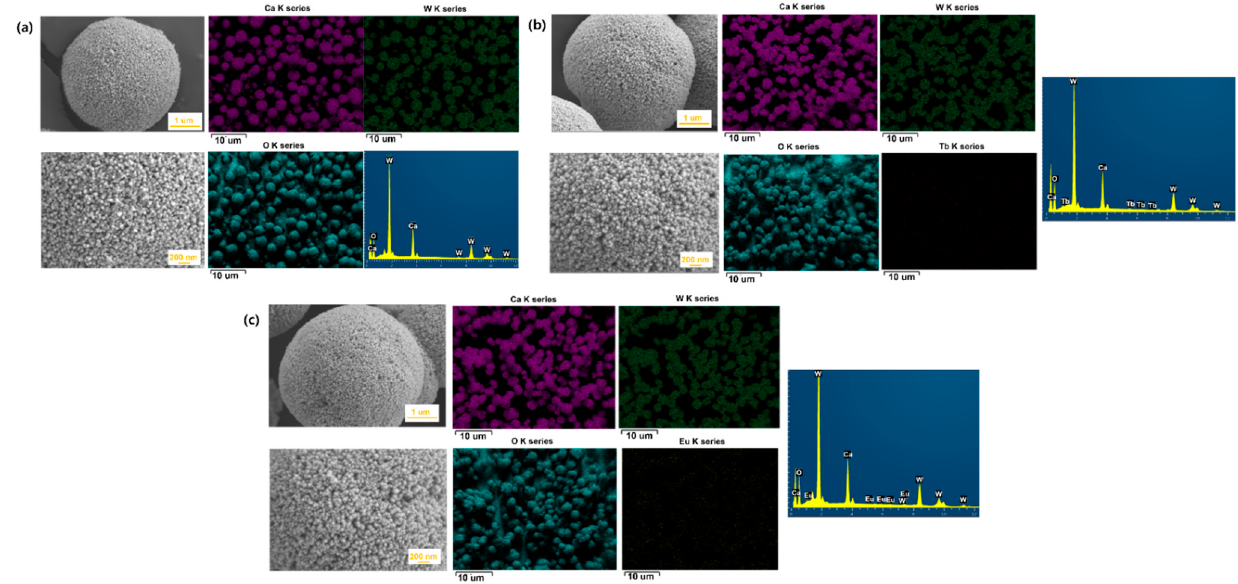
Figure 3. SEM-EDS analysis; ( a ) CaWO 4 , ( b ) CaWO 4 :Tb 3+ , and ( c ) CaWO 4 :Eu 3+ .